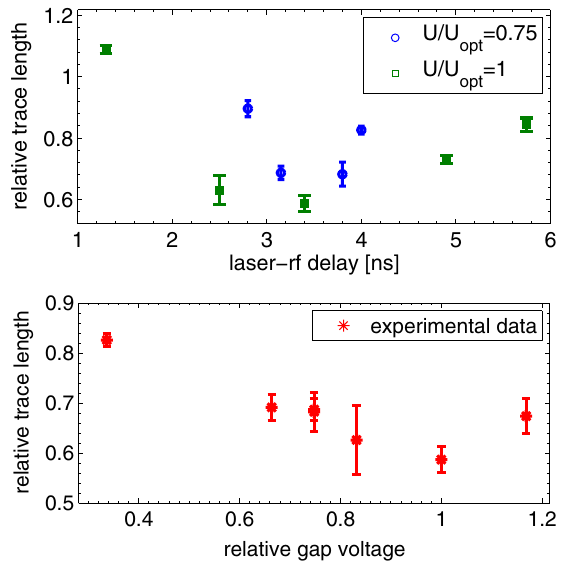
FIG. 4. The trace length on the dipole spectrometer is a measure of the energy spread. The minimum occurs at an injection phase of − 90 deg (upper graph). At this injection phase, the rf power is varied to find the optimum working point (again the minimum, lower